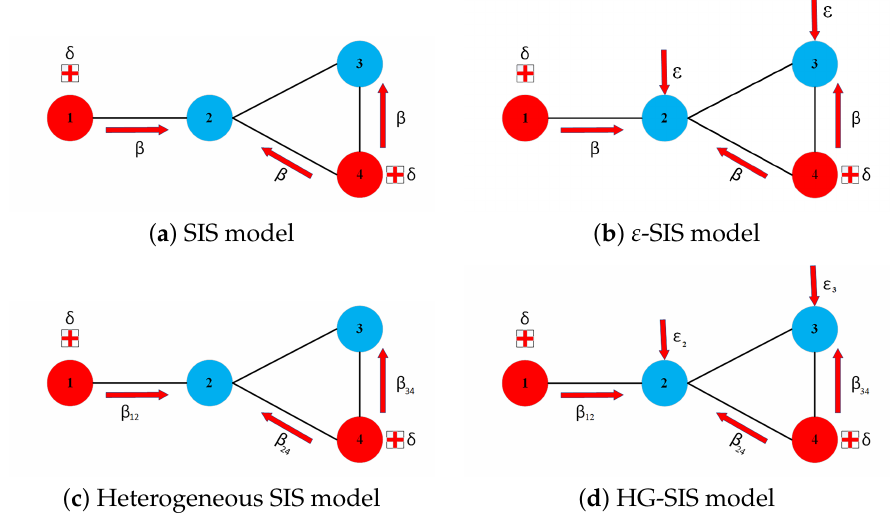
Figure 4. Illustration for the difference in the SIS model, ε -SIS model, heterogeneous SIS model, and HG-SIS model in the node-level framework. ( a ) SIS model. ( b ) ε -SIS model. ( c ) Heterogeneous SIS model. ( d ) HG-SIS